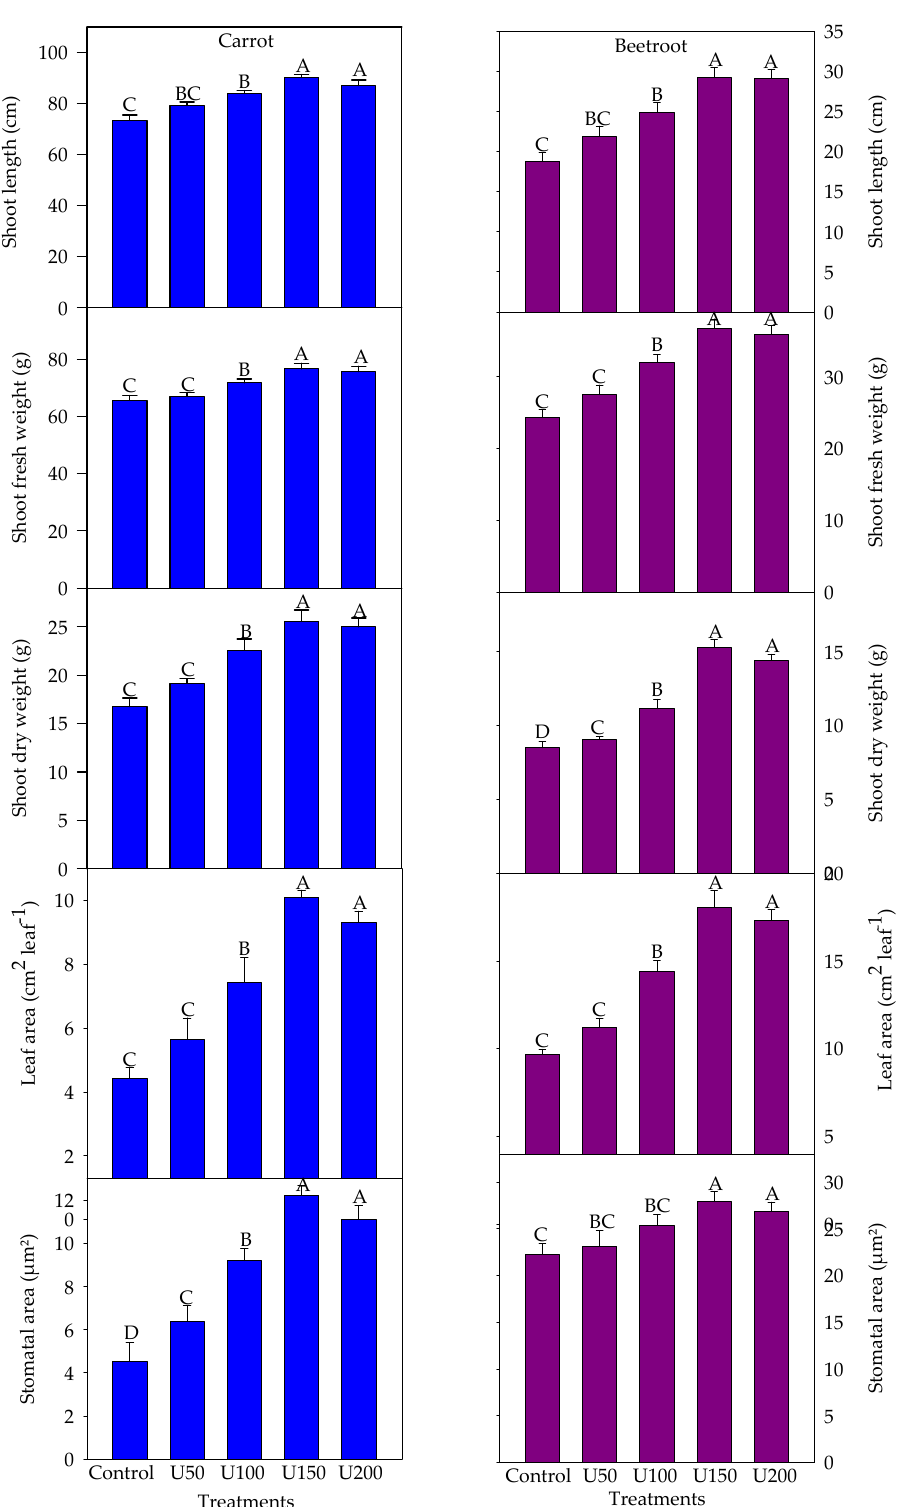
Figure 1. Impact of different N levels on the growth attributes of carrot and beetroot. Data from experiments are collected as the mean of three replicates ± standard error (SE). Different alphabets used indicate significant differences between treatments at p < 0.05, ( n =